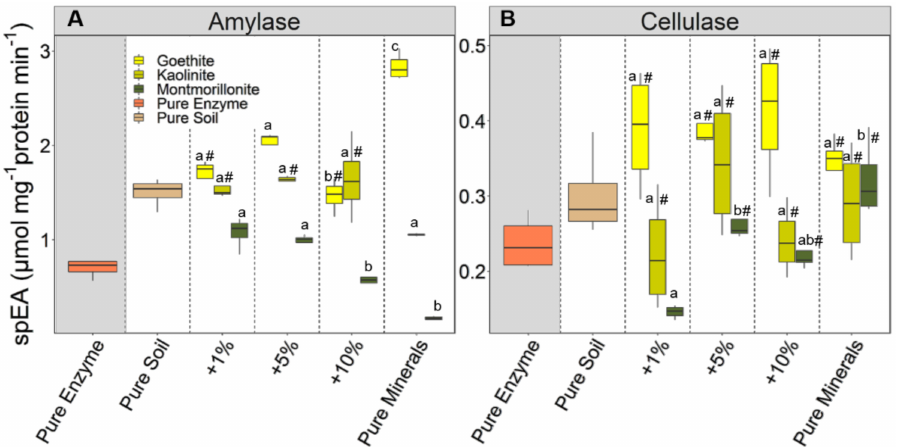
Figure 2. Relationship between the specific enzyme activity (spEA) of amylase ( A ) and cellulase ( B ) in response to additions of soil minerals (x-axis: pure enzyme, pure soil, soils with varying amounts of added minerals (+1%, +5%, and +10%), and pure minerals). Data present the spEA directly after addition of enzymes to the soil, with and without addition of minerals (montmorillonite, kaolinite, and goethite). Boxes (excluding the pure enzyme) marked with # are not significant ( p < 0.05 ) from the control (pure soil). Boxes with same letters are not significantly different from each other. Box–whisker plots depict the median (line within boxes), first and third quartiles (upper and lower end of boxes), and non-outlier range ( n = 4).